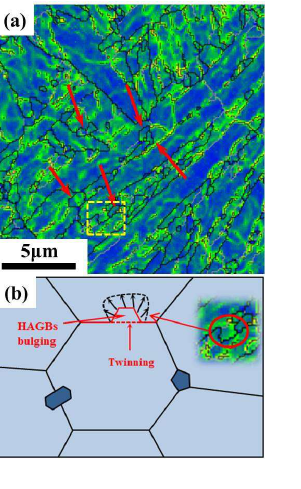
Figure 9. Evolutionary mechanism of recrystallization process ( a , b ) 950 °C/0.01 s −1 ; ( c , d ) 1050 °C/0.01 s −1 ; ( e , f ) 1150 °C/0.01 s −1 ; and ( g ) 1050 °C/1 s −1.